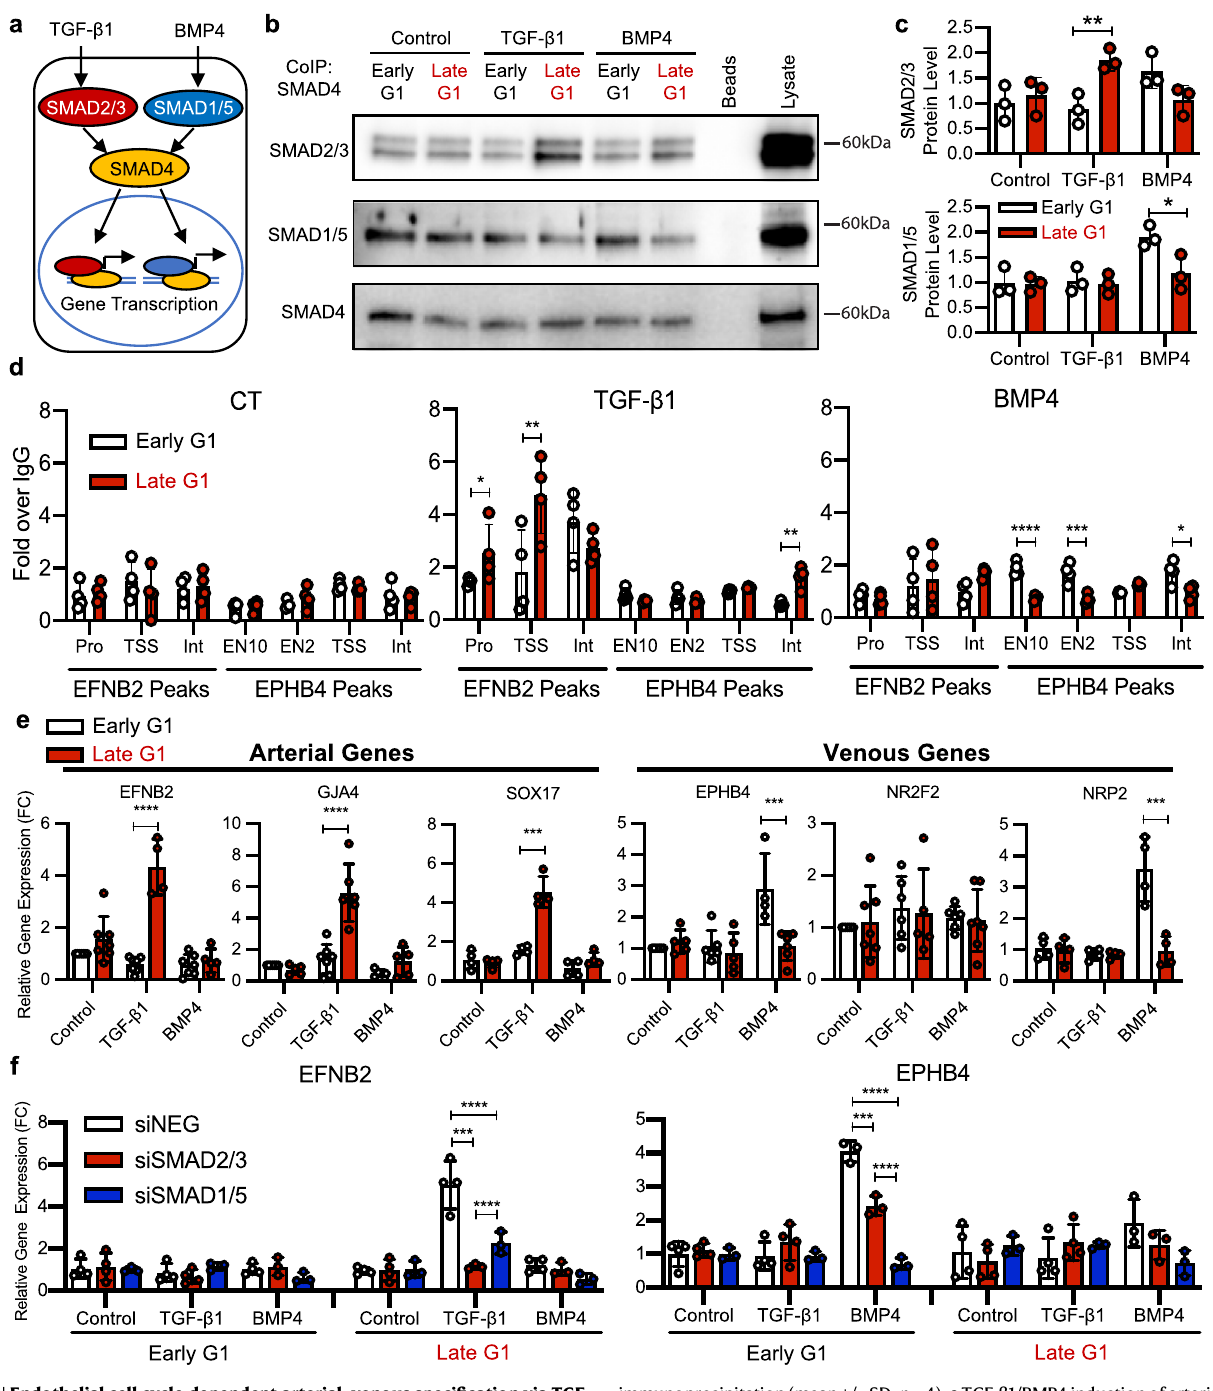
immunoprecipitation(mean+/ − SD, n =4). e TGF- β 1/BMP4inductionofarterialand venous genes in early G1 and late G1 HUVEC-FUCCI (mean+/ − SD, n =4 – 6). f TGF- β 1/BMP4 induction of EFNB2 and EPHB4 after NEG, SMAD2/3, or SMAD1/5 siRNA knockdowninearlyG1andlateG1(mean+/ − SD, n =4).Sourcedataareprovidedas a Source data fi le. Statistical comparison of means by two-way ANOVA post hoc Tukey, represented p -values as *<0.05, **<0.01, ***<0.001,